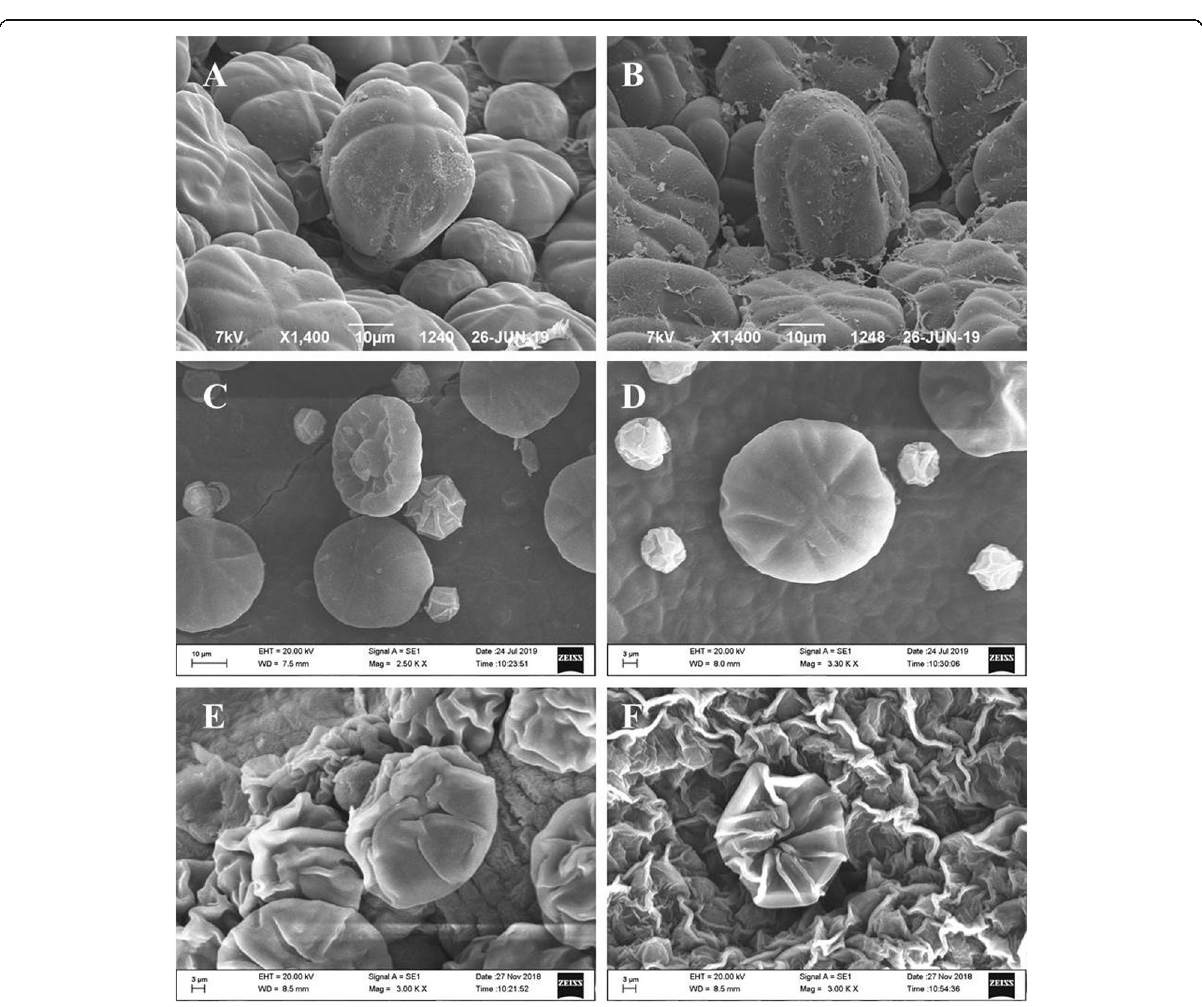
Fig. 4 Scanning electron micrograph of the M. hortensis leaf surface after CPD ( a and b ), HMDS ( c and d ), and air drying ( e and f ). All the samples were treated with OsO 4 as a secondary fixative while maintaining all of the sample preparation parameters, except for the final drying process. Scale bars represent 10 μ m in a , b , and c and 3 μ m in d , e , and